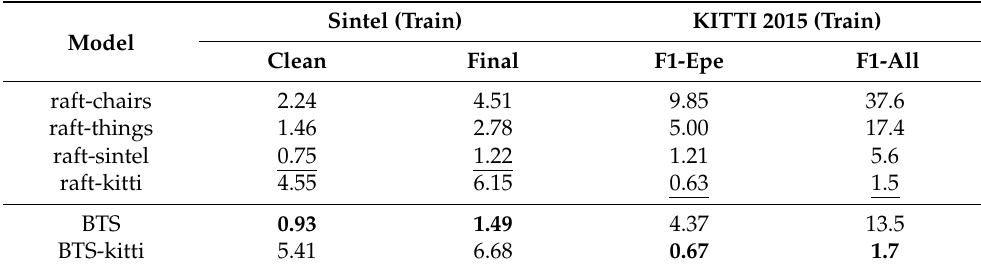
Table 3. Experimental results of end-point-error (EPE) on original optical flow datasets.